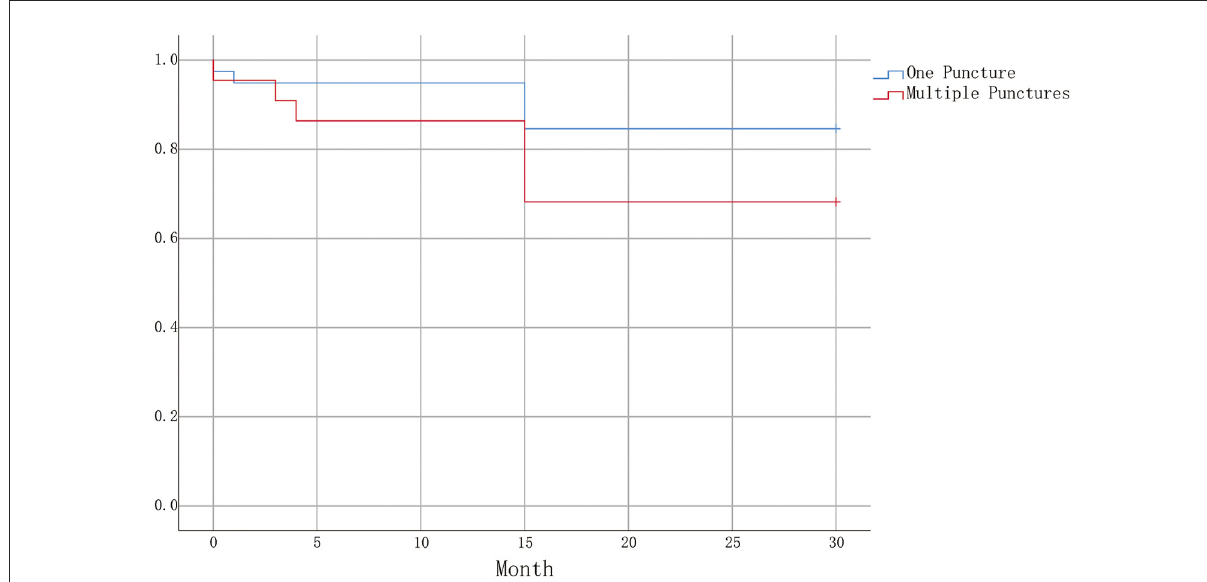
FIGURE4 Kaplan-Meier plot illustrating survival curves for one puncture and multiple punctures. A statistically significant difference was not obtained (Log-Rank test P =